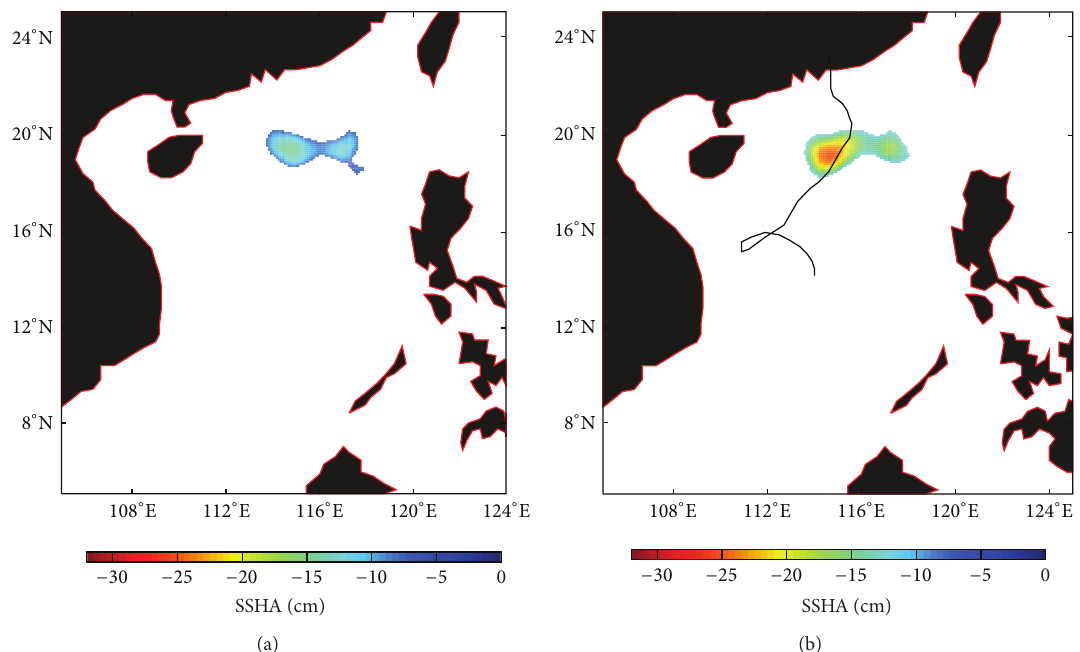
Figure 6: The SSHA images show the CCE which was passed by typhoon Leo. (a) SSHA on 28 April, 1999. (b) SSHA on 5 May, 1999. The black solid line is the track of